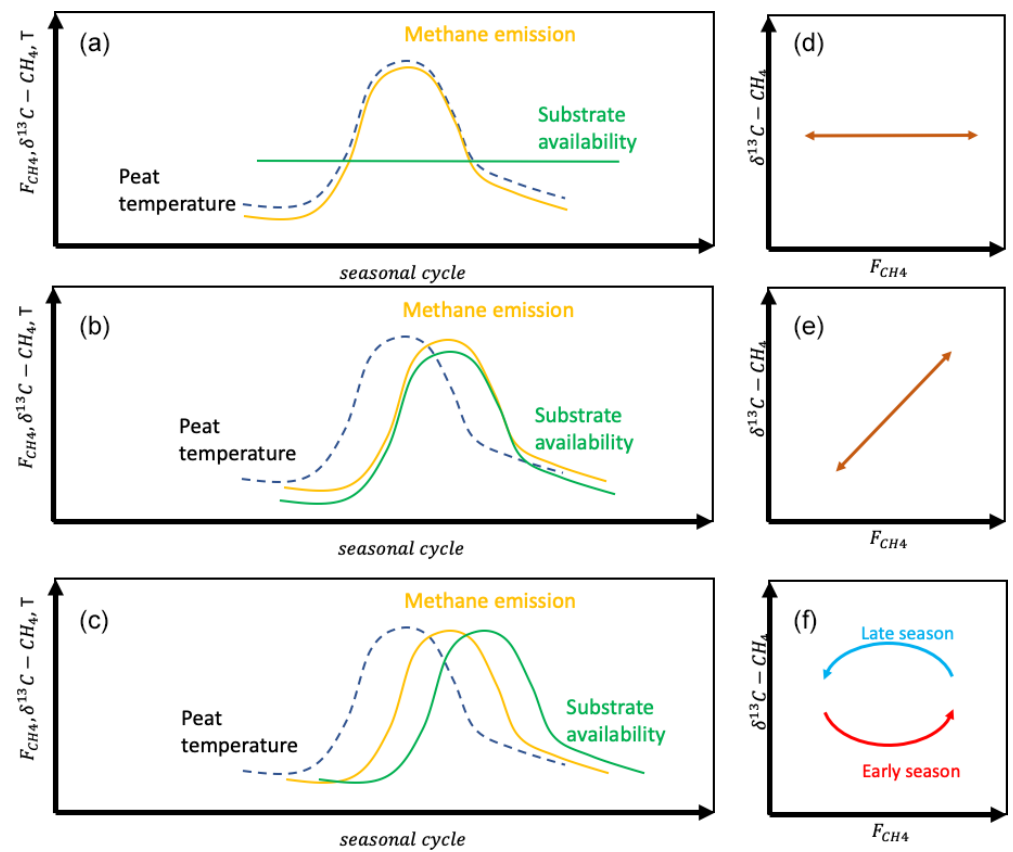
Figure 2. Seasonal variation in methane emission with hypotheses on controlling processes ( a HT1; b HT2; c HT3) and resulting relations (d–f) . between δ 13 C-CH 4 and F CH 4 Table 1. Dominant vegetation in flux chambers. D: dominant; P: present. Niche indicates the niche of the species. The relative elevation (above 80ma.s.l.) of the moss surface at each chamber (CH_1 to CH_6) is